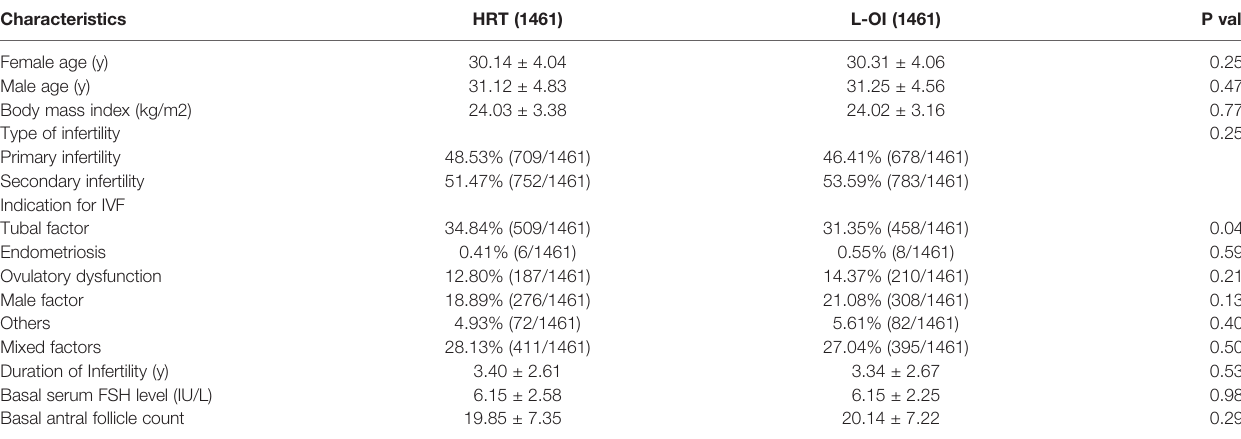
TABLE 2 | Patient clinical characteristics after PSM.